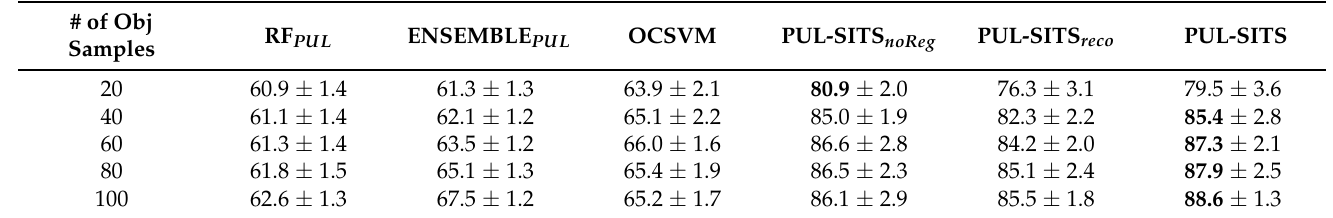
Table 5. Performances in terms of the Accuracy of the different competing strategies when the land cover class of interest (the positive class) is Cereals/Oilseeds .